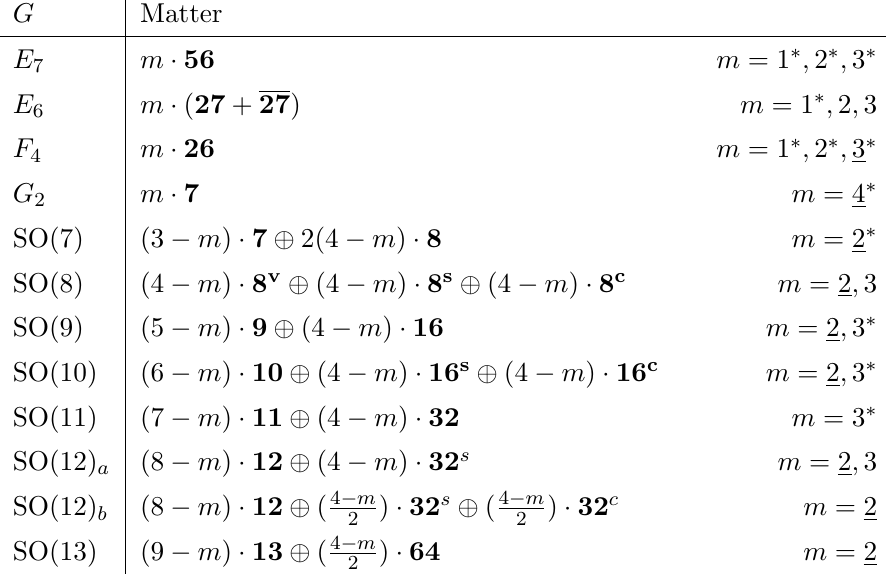
Table 89. Choices of gauge and matter content of 5d theories for which we obtain novel results for the one-instanton partition function. For the values of m which are underlined, the one-instanton partition function contains extra gauge-neutral states in comparison to the Nekrasov partition function (as discussed in section 7). We denote by an asterisk the theories for which we are able to determine the one-instanton partition function to all orders in v with chemical potentials m F and m G turned on; for the remaining theories we are only able to obtain partial information about the dependence on m F and m G